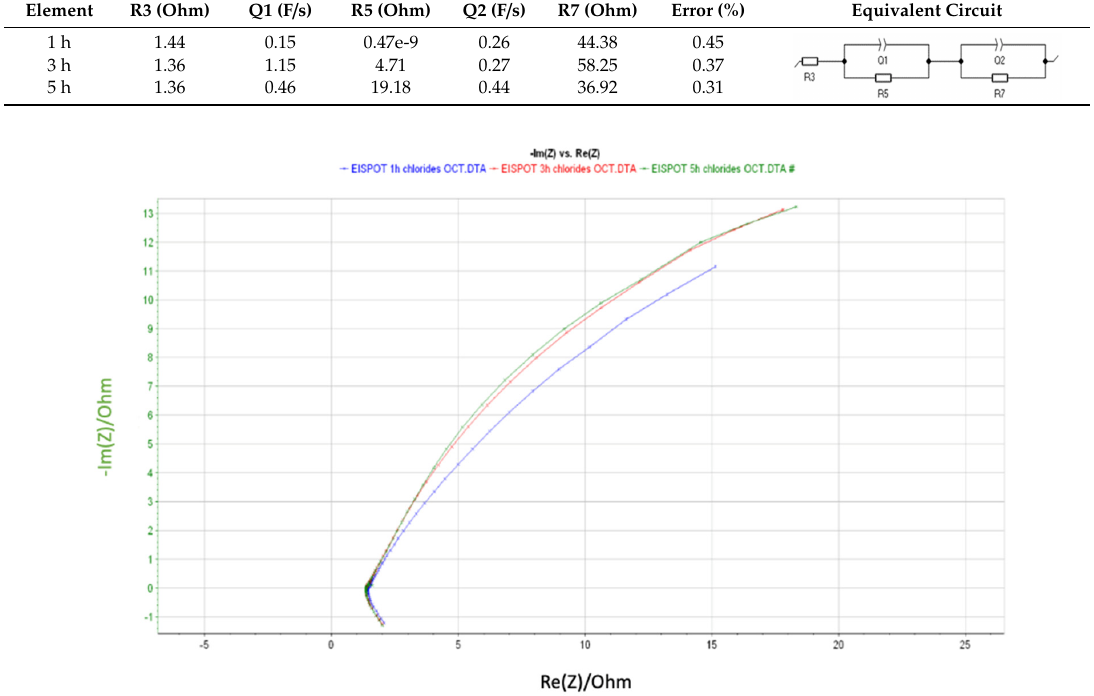
Figure 7. Nyquist diagram of OCT immersed in ternary chloride molten salt for 1, 3, and 5 h.